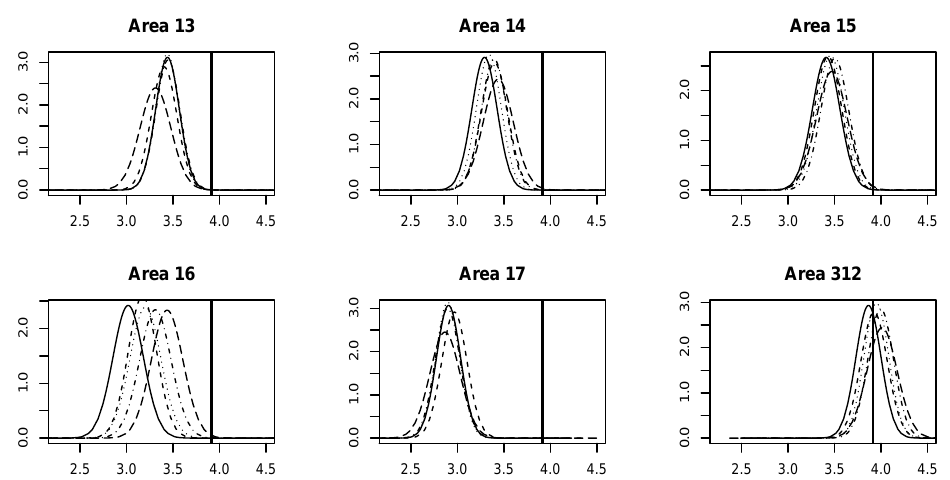
Figure 5. Marginal distributions of the median housing values for 6 of the 16 areas with censored observations, Boston housing data with full adjacency matrix. The legend is as in Figure 4. Vertical lines show where the censoring cuts in.